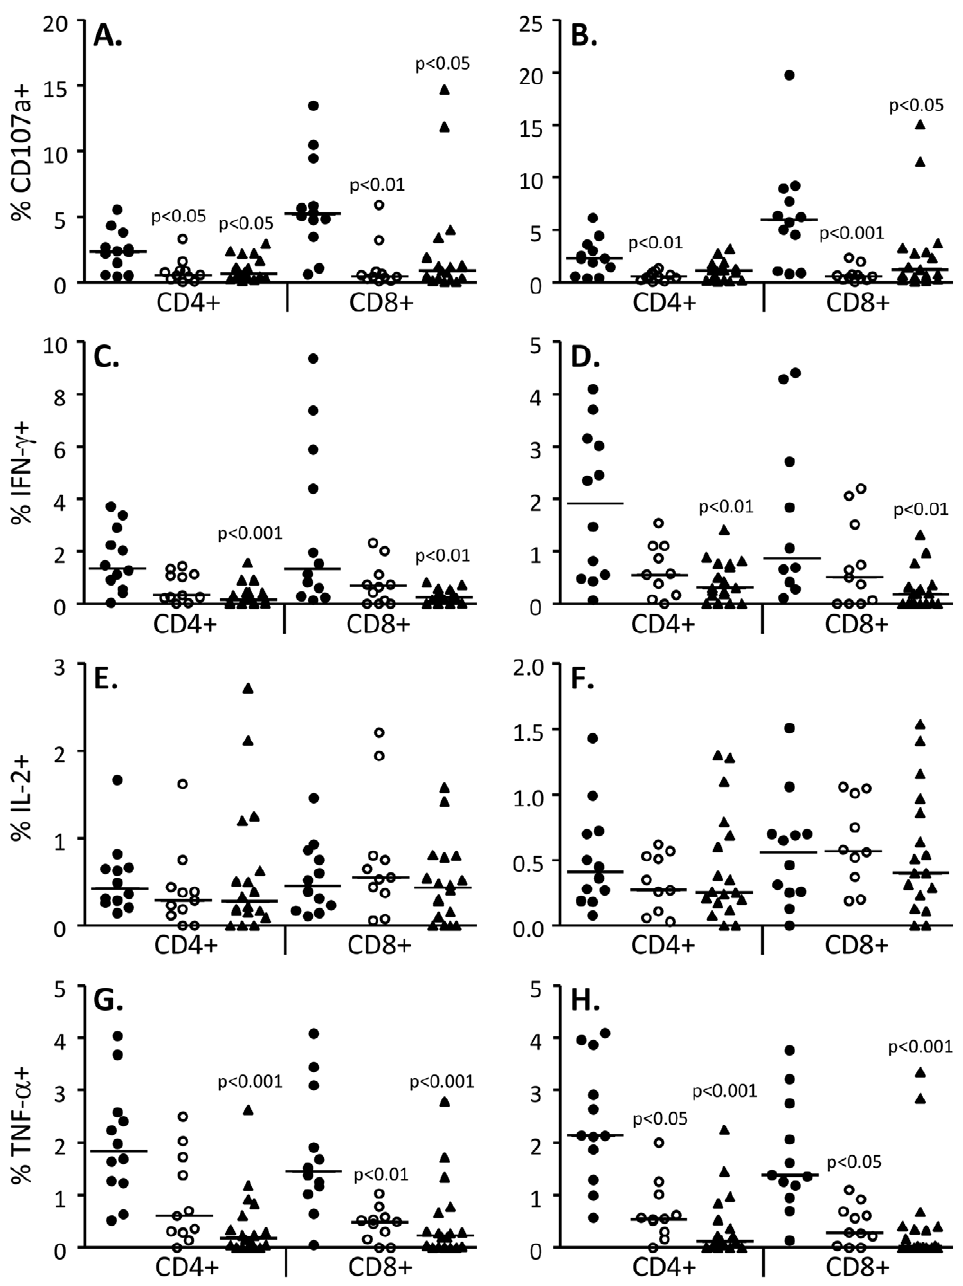
Figure 2. Increased CD107a, IFN- c and TNF- a expression in TB cases pre-treatment and reduction post-treatment. Bar indicates median of TB cases pre-treatment (n=12, filled circles), TB cases post-treatment (n=10, open circles) and 17 HHC (triangles). Data were analysed using a Kruskal-Wallis ANOVA followed by Dunn’s post-test comparison and p-values indicated.